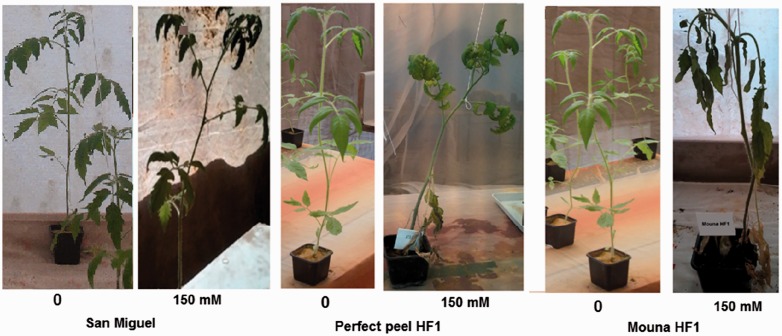
Visual appearance of the three selected genotypes growing in saline and non-saline conditions.